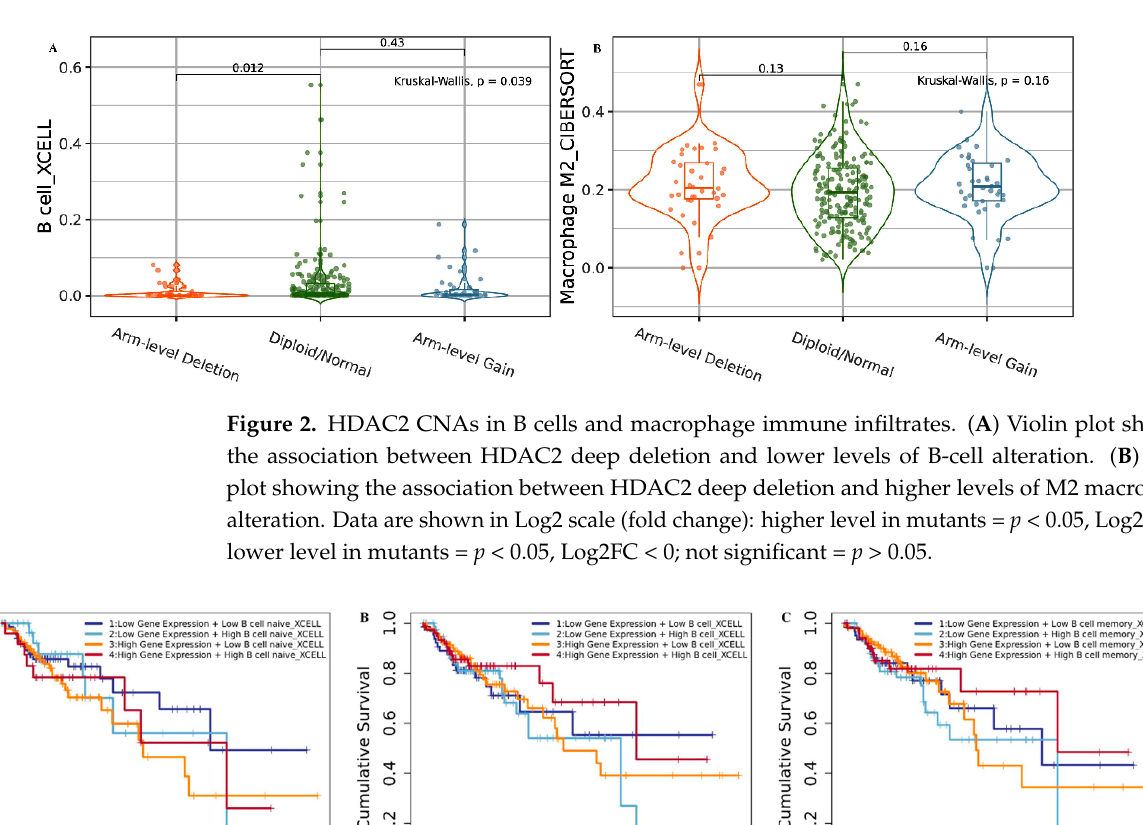
Figure 2. HDAC2 CNAs in B cells and macrophage immune infiltrates. ( A ) Violin plot showing the association between HDAC2 deep deletion and lower levels of B-cell alteration. ( B ) Violin plot showing the association between HDAC2 deep deletion and higher levels of M2 macrophage alter- ation. Data are shown in Log2 scale (fold change): higher level in mutants = p < 0.05, Log2FC > 0; lower level in mutants = p < 0.05, Log2FC < 0; not significant = p > 0.05.